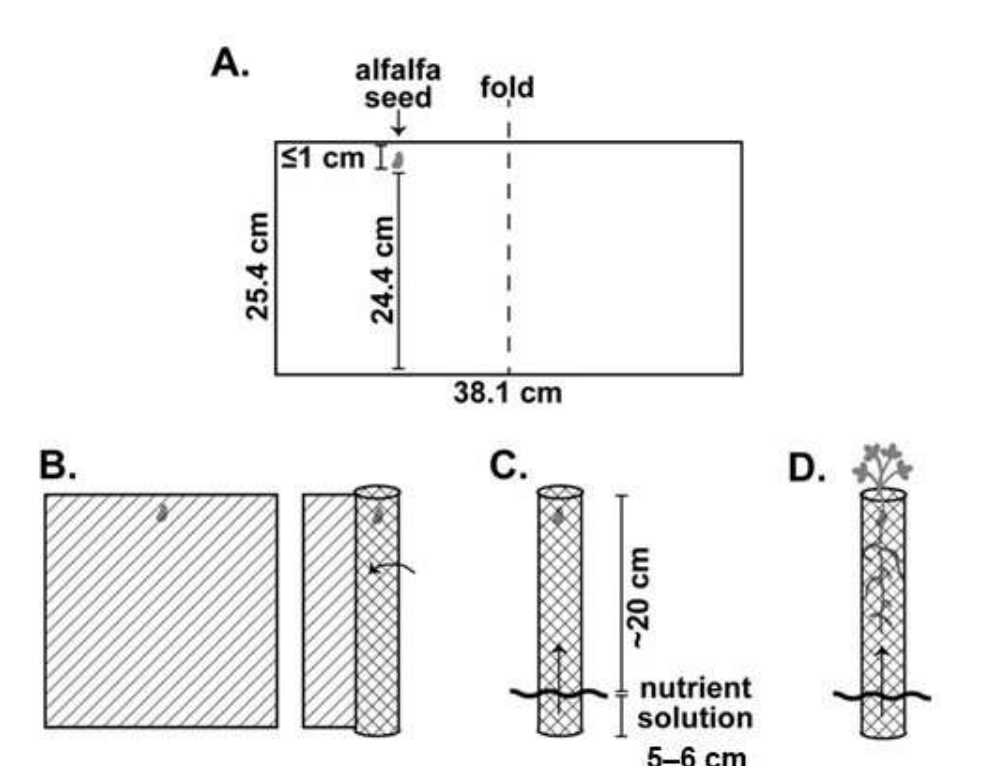
Figure 1. Alfalfa plants were grown hydroponically to be tested against CRC larvae. ( A ) One rhizobia-inoculated (Nitragin ® Gold, Monsanto, St. Louis, MO, USA) alfalfa seed was placed no more than 1 cm from the top edge of a moistened germination paper (38.1 × 25.4 cm) (Anchor Paper Inc, St. Paul, MN, USA), which was then folded in half. ( B ) Papers with seeds were rolled into cylinders, and ( C ) placed into containers filled with a hydroponic growth solution (0 N-10 P-10 K, Alaska Morbloom, Central Garden and Pet Company, Walnut Creek, CA, USA; Immunox Multi-purpose Fungicide, Spectracide, Spectrum Brands, Madison, WI, USA) covering the bottom 5–6 cm of papers. Capillary action through the papers appropriately moistened seeds for germination and growth. ( D ) Plants were grown for approximately 2–4 months prior to use in larval trials.